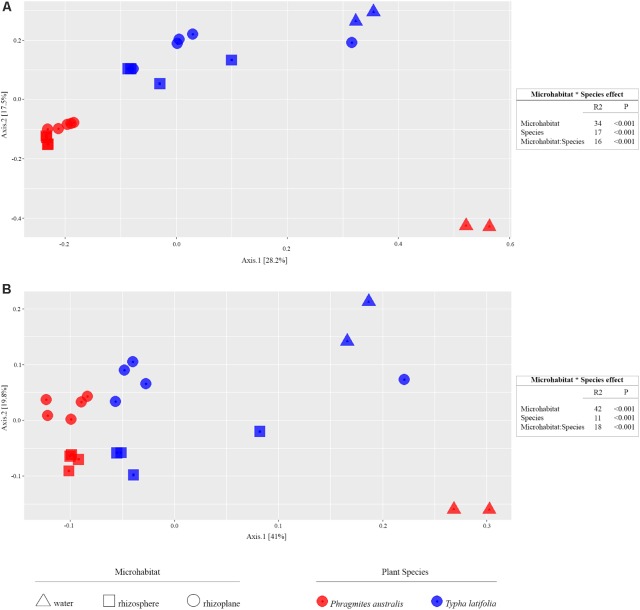
Beta-diversity calculation. On the left, the PCoA plots show the distance between samples calculated using Bray–Curtis index sensitive to the OTUs relative abundance (A, left) and weighted UniFrac index sensitive to both OTU relative abundances and taxonomic affiliation (B, left); the colors of shown symbols depict the plant species and their shapes indicate the considered microhabitats. On the right, the permutational analysis of variances for the indicated sources of variation calculated for the Bray–Curtis (A, right) and weighted UniFrac (B, right) indexes. The R2 value shows the proportional effect of the indicated factors in the samples distancing and the p-values were calculated for 5,000 permutations.